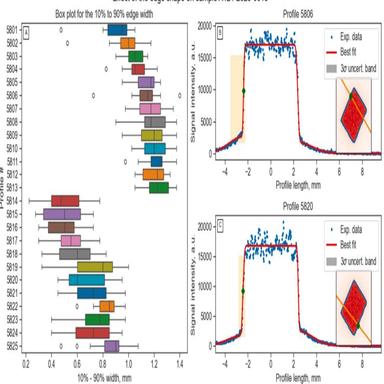
Influence of sample thickness on edge width in embedded samples exemplified on a natural UO2 sample embedded in EPOFIX. (A) Box plot showing the distribution of edge widths for 25 intensity profiles. Profiles 5801–5813 represent the thick edge, while profiles 5814–5825 represent the thin edge. (B) Example profile from the thick side, and (C) example profile from the thin side.